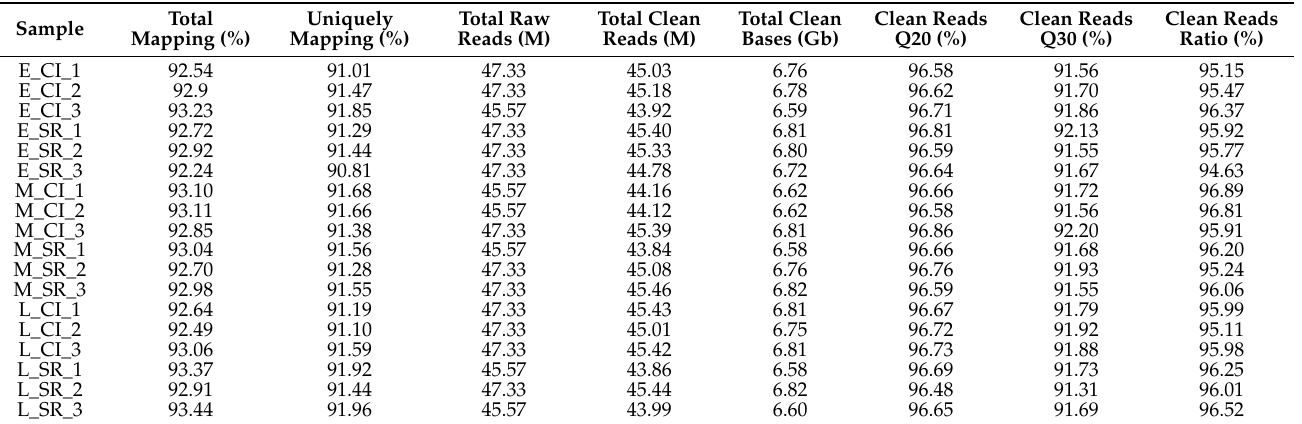
Figure 1. Images of paraffin sections of tomato inflorescences. ( A ): represents E_CI, and E_CI represents the early stage of the compound inflorescence. ( B ): represents M_CI, which represents the middle stage of the compound inflorescence. ( C ): represents E_SR, and E_SR represents the early stage of a single raceme. ( D ): represents M_SR, which represents the metaphase of a single raceme. Table 1. Statistics of the tomato transcriptome